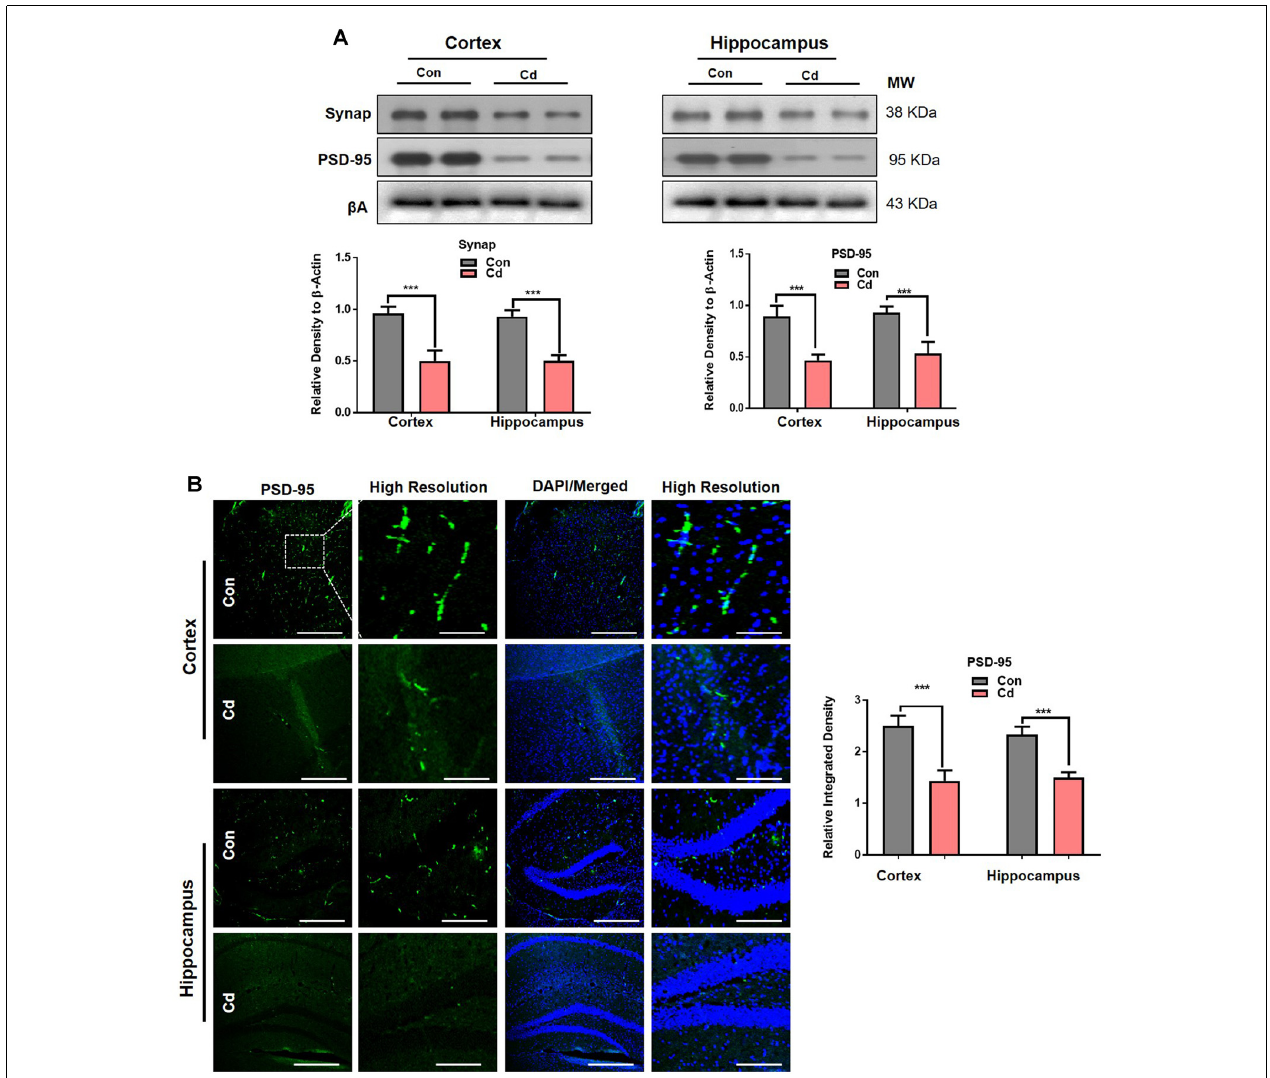
FIGURE 3 | Cd exposure induced synaptic dysfunction in mice. (A) Western blot images against presynaptic (Synap) and postsynaptic (PSD-95) protein markers in the cortical and hippocampal regions of the brain and their respective histograms. β -Actin was used as a loading control. The histograms represented as the means ± SEM ( n = 7 mice/group) for three independent repeated and reproducible experiments. Significance = *** p < 0.001; Student’s unpaired t -test. See Supplementary Figure 1 for uncropped and original blots. (B) Representative immunofluorescence images of PSD-95, respectively (green: FITC and blue: DAPI) in the cortical and hippocampal regions of the mouse brain. The histograms represented as the means ± SEM for n = 5 mice per group, and the number of independent experiments = 3. Magnification: 10 × . Scale bar = 50 µ m. Significance = *** p < 0.001; Student’s unpaired t